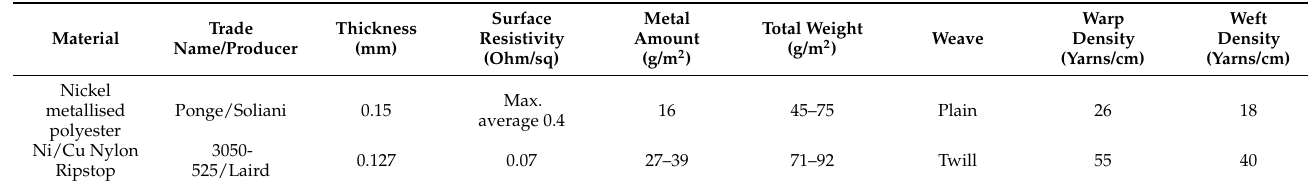
Table 1. The basic parameters of the electroconductive fabrics used in this study.